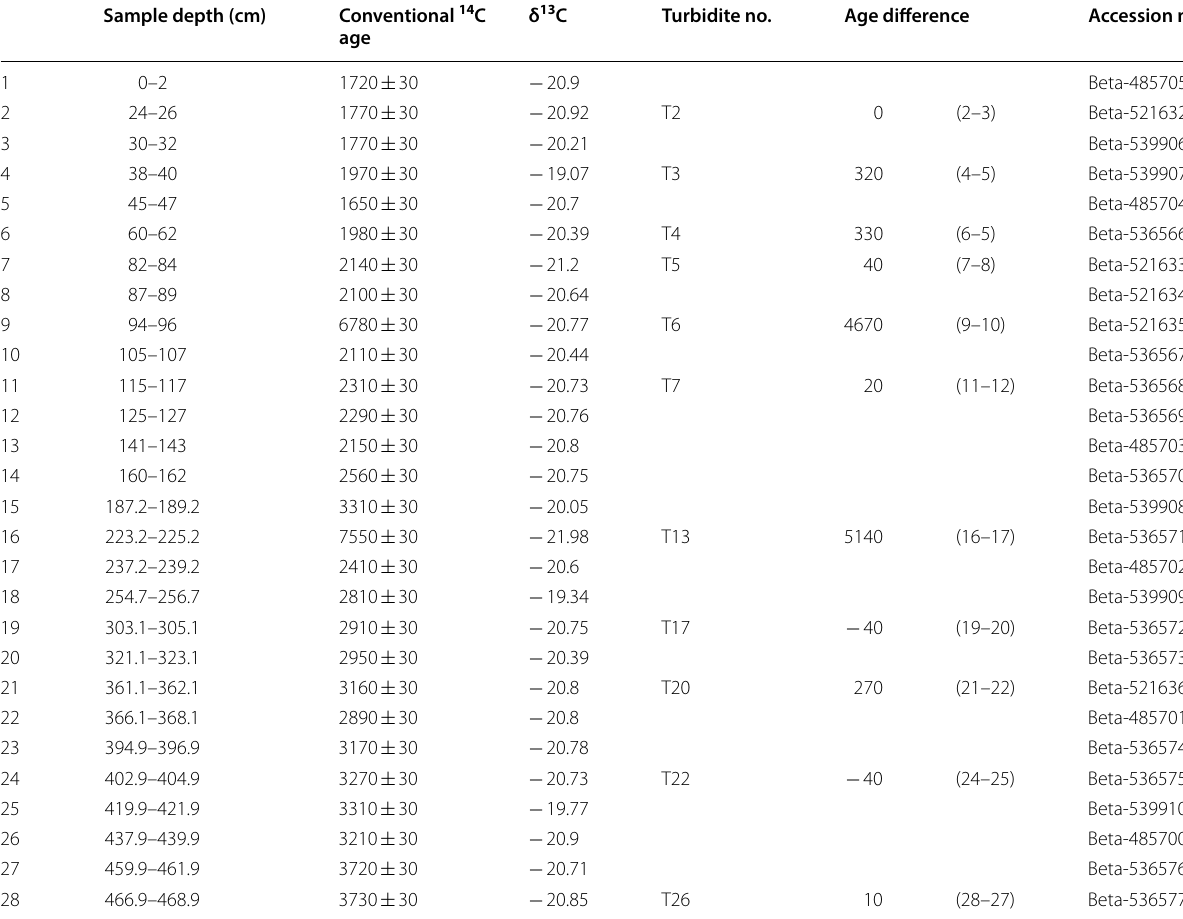
Table 1 Results of radiocarbon age determinations and age differences between turbidite muds and hemipelagic muds of the examined 11